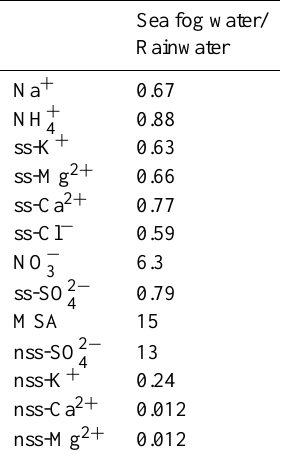
Table 3. Sea fog water/rainwater ratios for major ionic species in terms of concentrations (µeqL − 1